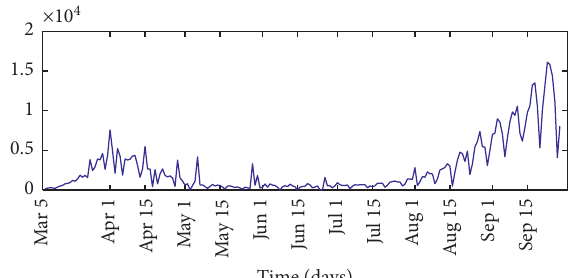
Figure 3: Daily reported COVID-19 cases from 5 th March 2020 to 29 th September 2020, France (source: Worldometer).